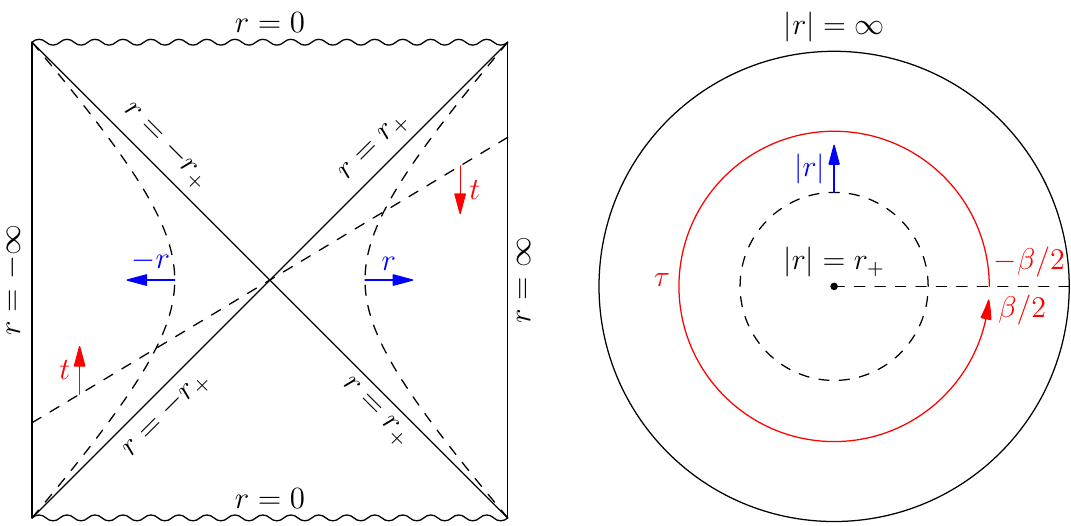
Figure 1. The non-rotating BTZ black hole: Lorentzian signature (left) and Euclidean signature (right). The Euclidean black hole has periodic time τ ∼ τ + β , where β = 1 /T